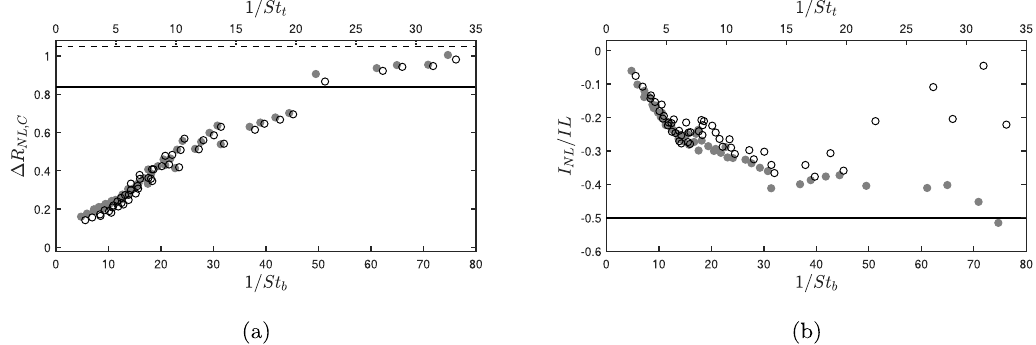
Figure 9. Change in a) slit resistance and b) slit inertance due to non-linearity for long ( ) and short ( ) slits as function of St b and St t for several amplitudes at the reference microphone ( ^ p x ref ð Þ (cid:10) 10 Pa). Lines are de fi ned as in Figure 8.